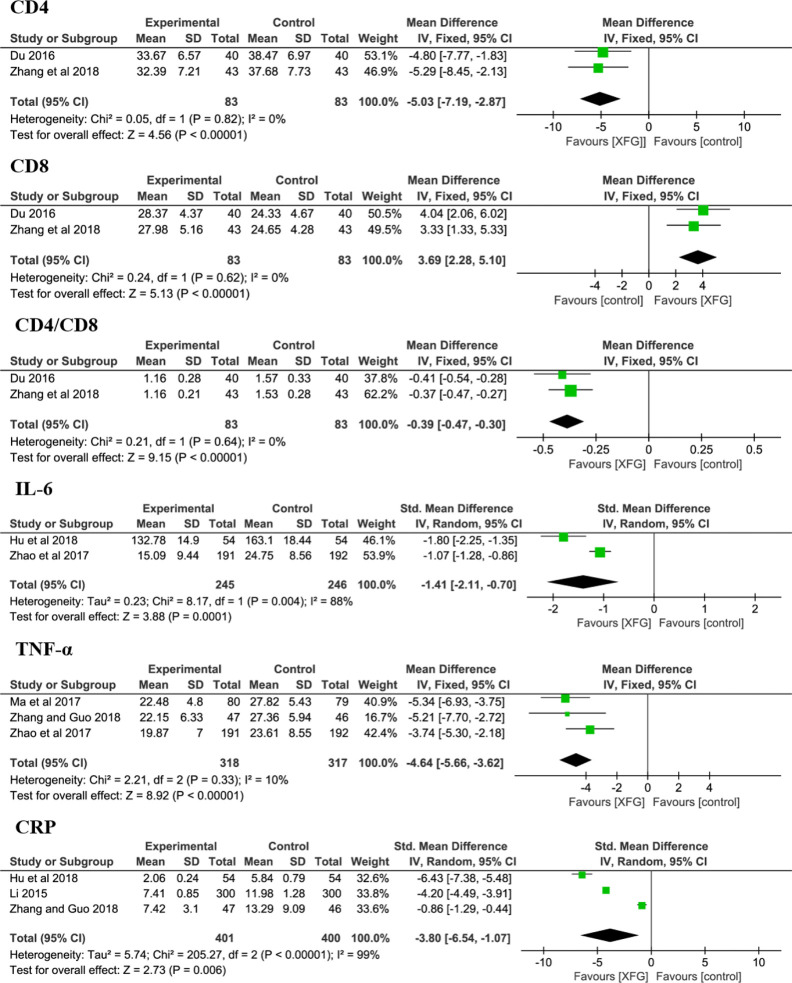
Forest plot and meta-analysis of CD4, CD8, CD4/CD8, IL-6, TNF-α, and CRP levels.